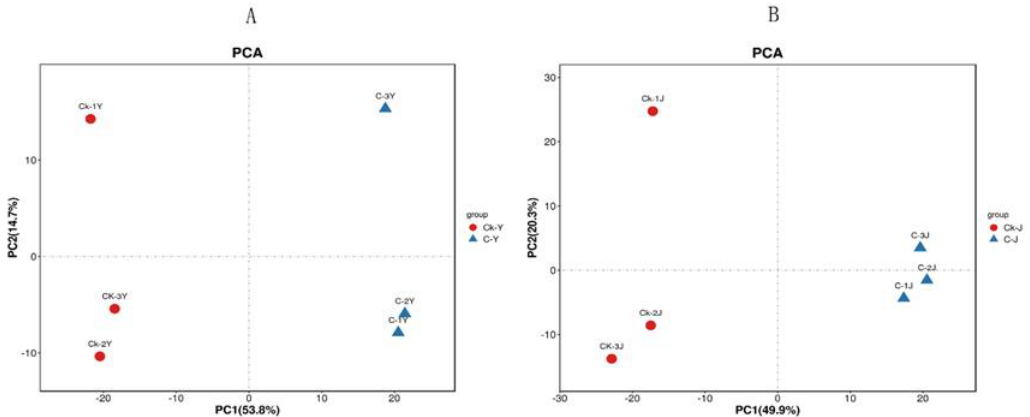
Figure 7. Plots of Principle Component Analysis Showing Metabolic Alterations by the GA 3 and ETH Treatment. Two plots show differentiations of 99 metabolites in treated (C-Y) vs. control (CK-Y) leaves ( A ) and of 88 metabolites in treated (C-J) vs. control (CK-J) stems ( B ).